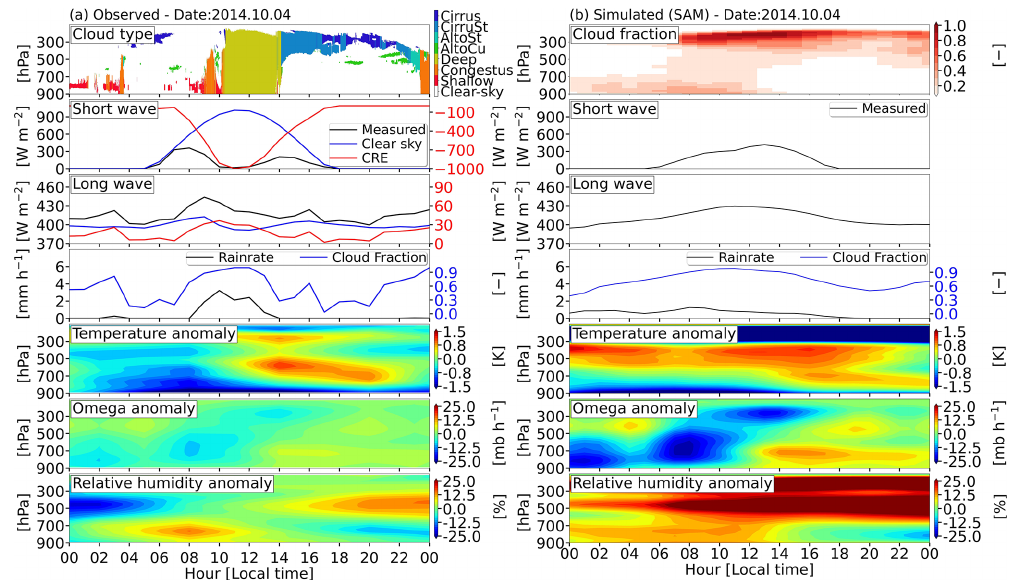
Figure 6. Daily cycle of cloud type, cloud fraction profile, and longwave and shortwave radiation fluxes for cloud and clear sky (Wm − 2 ), precipitation rate (mmh − 1 ), integrated cloud fraction and temperature (K), omega (mbh − 1 ), and relative humidity (%) anomaly from 4 Oc- tober 2014 for the (a) observed data and (b) simulated with the SAM model.